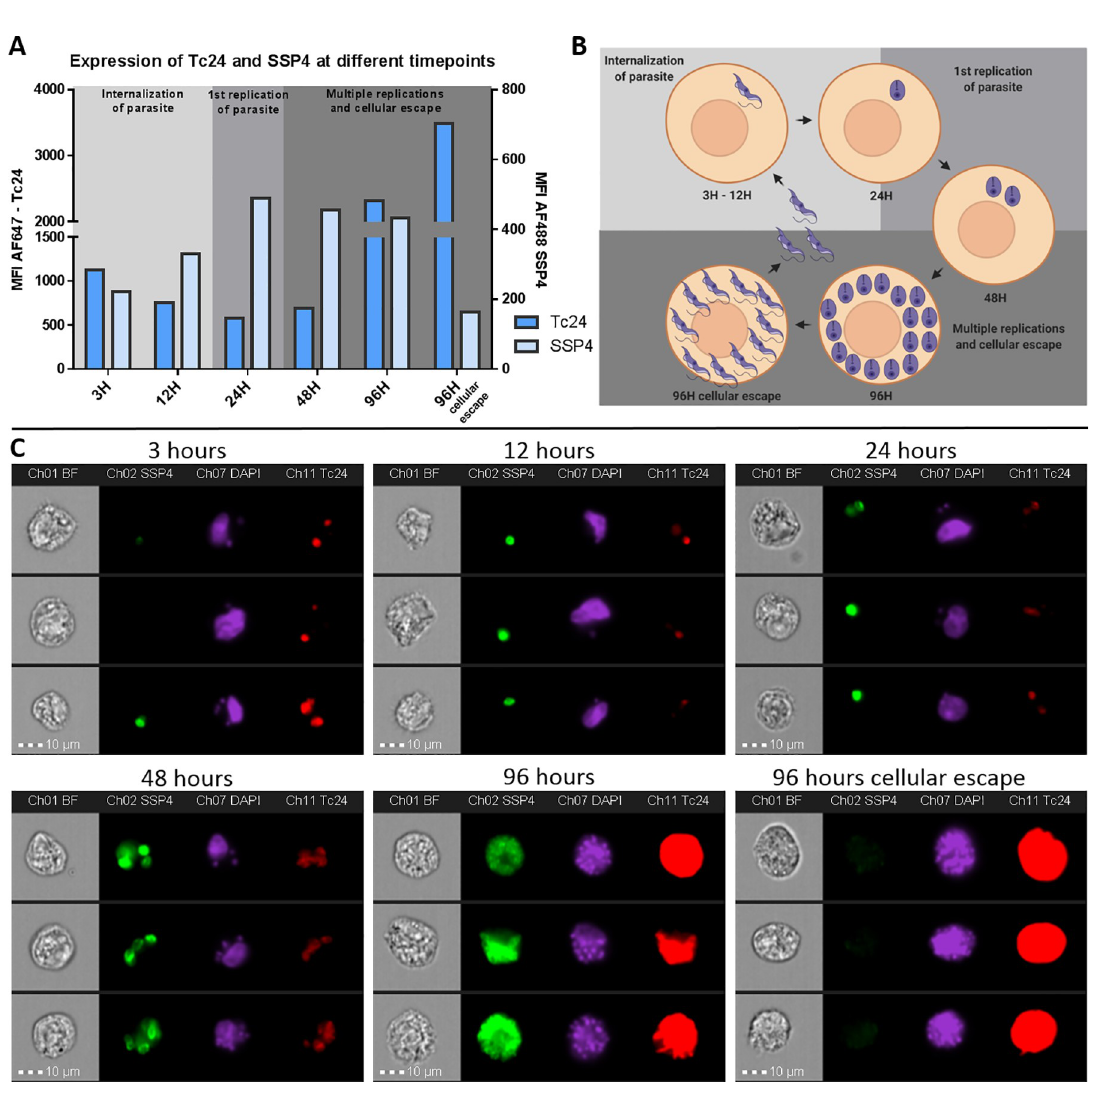
Fig 7. Imaging Flow Cytometry reveals a change in expression of Tc24 and SSP4 during different infection timepoints of T . cruzi . VERO cells were infected with T . cruzi and 3 hrs, 6 hrs, 12 hrs, 24 hrs, 48 hrs and 96 hrs after start infection fixed and permeabilized. VERO cells were then stained for Tc24 and SSP4. Nuclei were stained using DAPI. A) The MFI of Tc24 and SSP4 from the total population of T. cruzi —infected VERO cells was plotted in a histogram. The left y-axis depicts the MFI for Tc24 and the right y-axis depicts the MFI for SSP4. B) A schematic representation of the transformation of T . cruzi trypomastigotes to amastigotes and back to trypomastigotes in the VERO host cell is shown. Prepared using Biorender.com C) Image gallery of three events of each infection time point representing the complete population. Presented are brightfield, Tc24 (red), SSP4 (green) and DAPI (magenta).